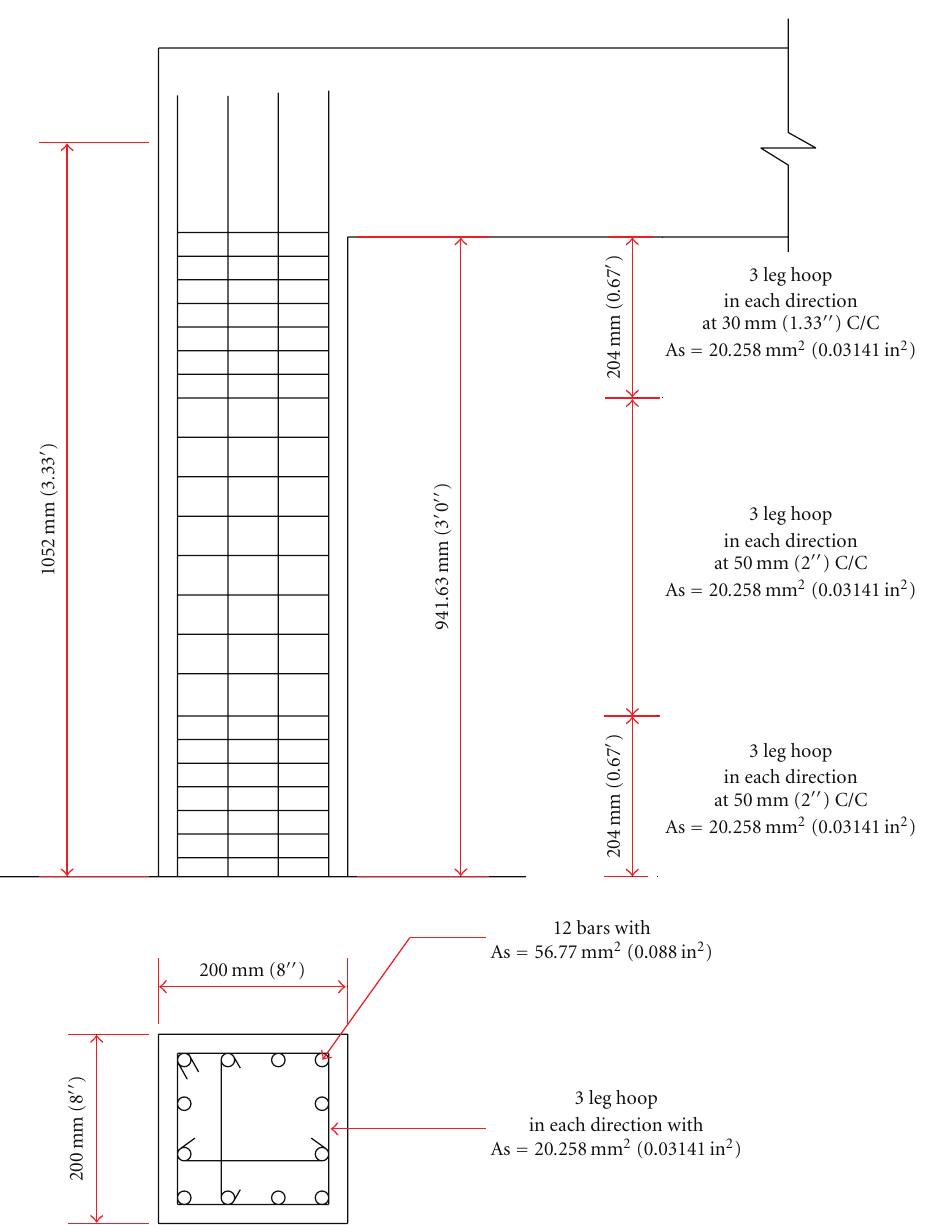
Figure 7: Reinforcement detail of the 1/3rd scaled column.